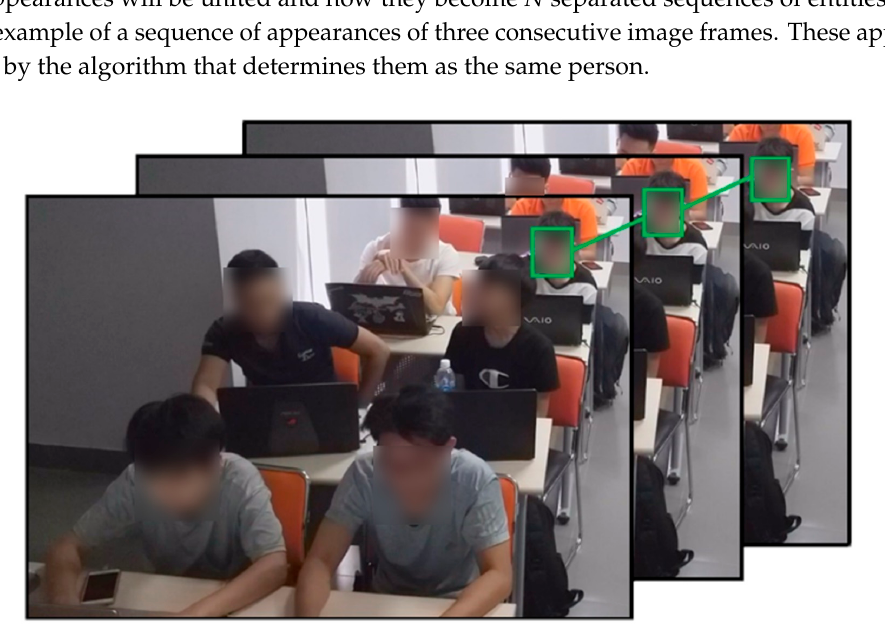
Figure 4. An example of united entities.